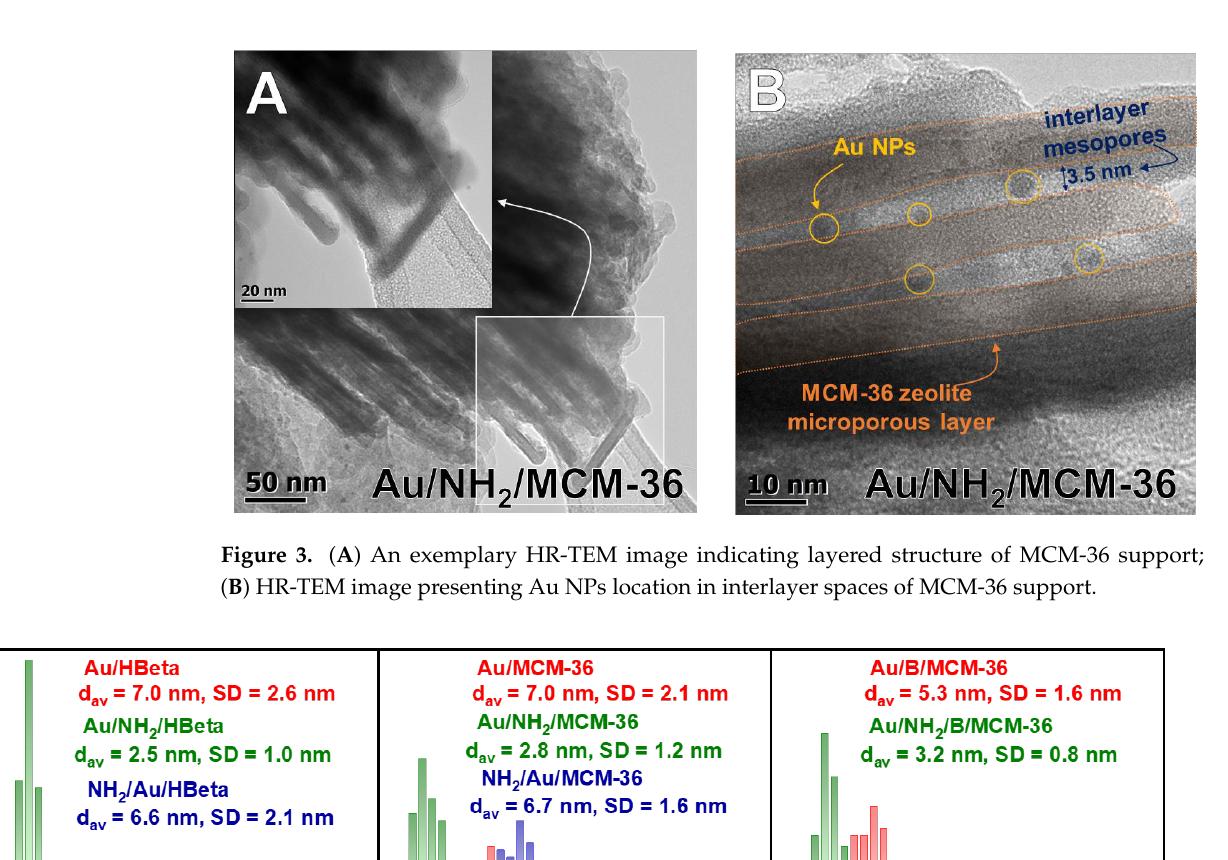
Figure 2. HR-TEM images of investigated gold catalysts. Scale bars are equal to 20 nm in each case.